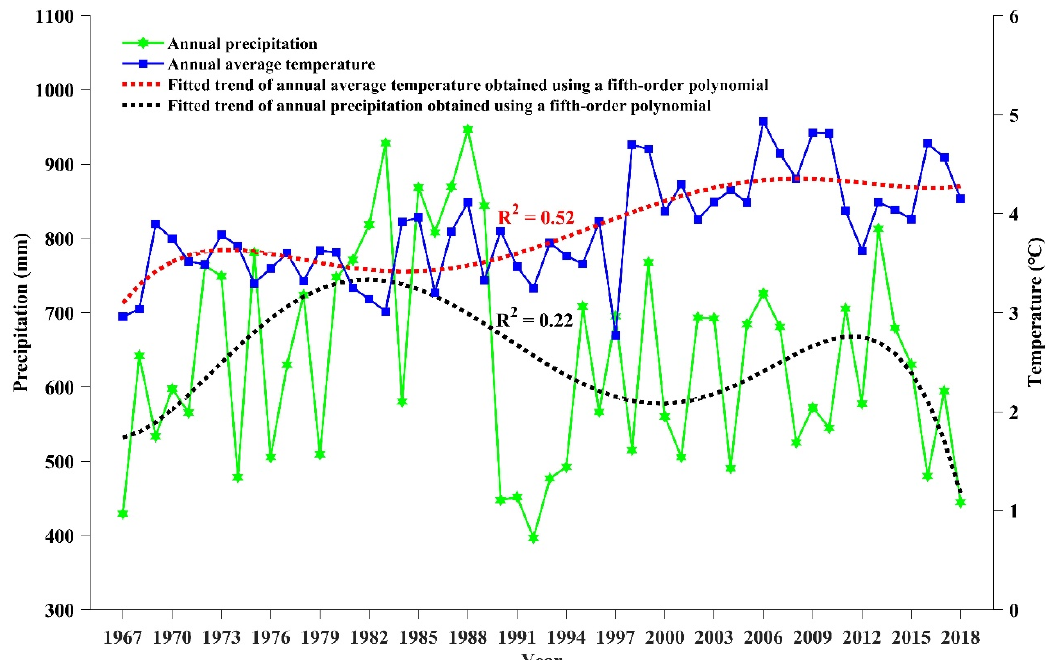
Figure 10. Annual cumulative precipitation and annual average temperature recorded by the Nyalam meteorological station in the Xixabangma massif from 1967 to 2018.